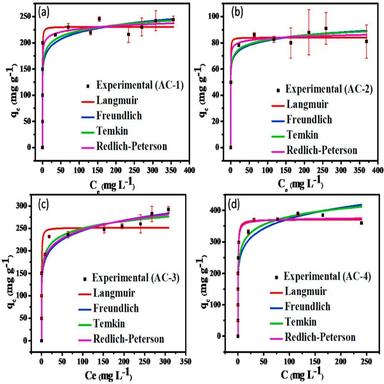
Adsorption isotherms of MB onto(a) AC-1, (b) AC-2, (c) AC-3 and (d) AC-4 after attaining equilibrium after6 h of agitation, initial concentration of50–600 mg L− 1 , dosage of 1 g L− 1 , pH 7.0 and temperature 298 ± 1 K.